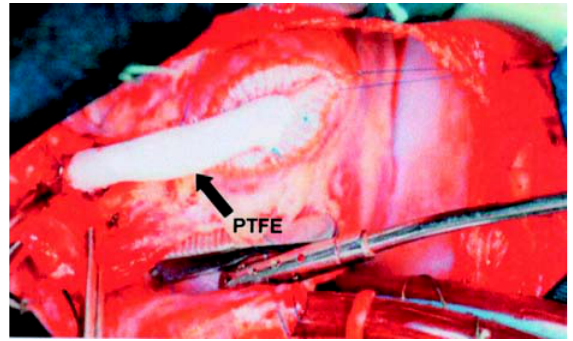
Fig. 9 – Conexão entre o ventrículo direito e artérias pulmonares com tubo de politetrafluoretileno